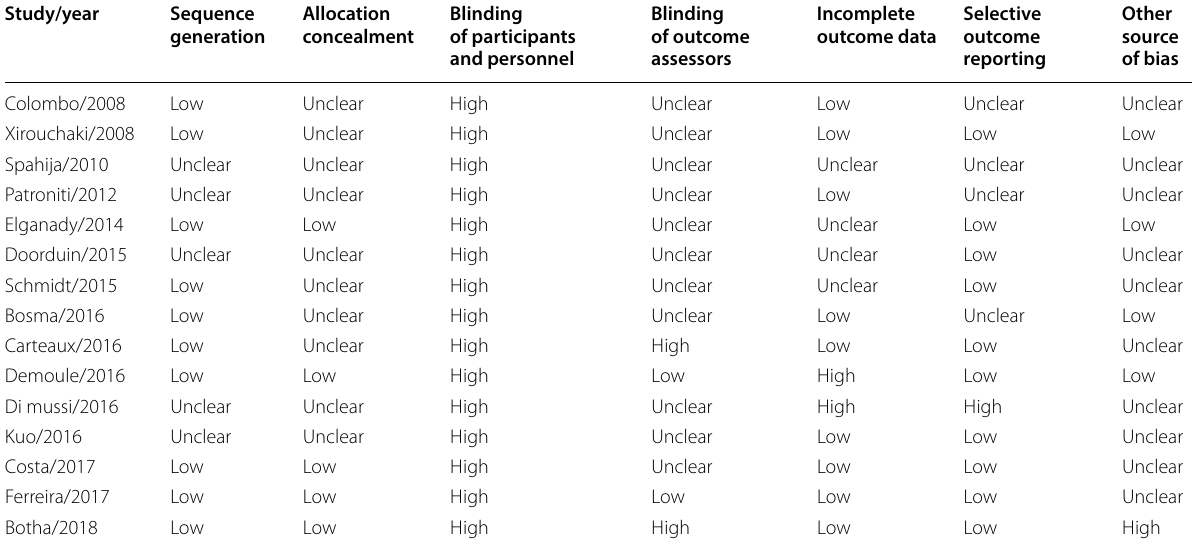
Table 2 Risk of bias in included studies